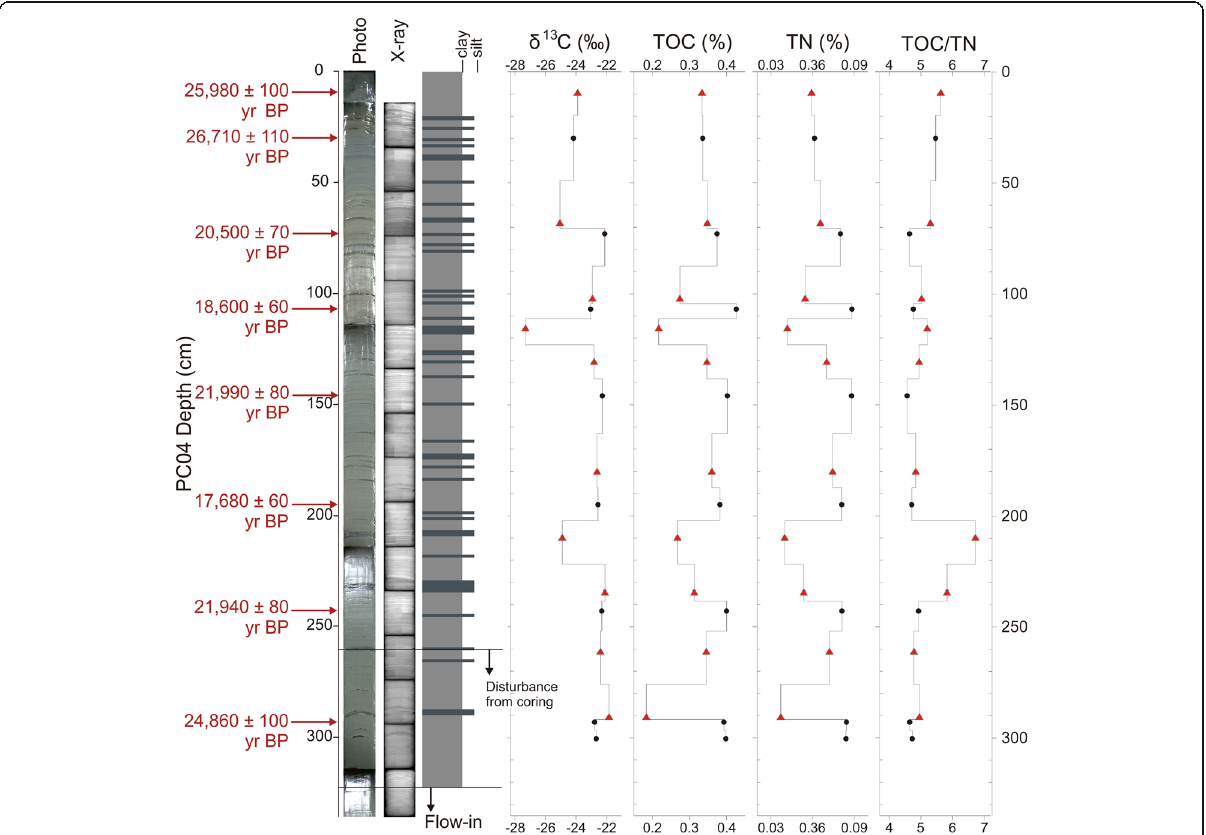
Fig. 7 Geochemical results from core PC04, including radiocarbon ages, stable carbon isotopic compositions ( δ 13 C), total organic carbon contents (TOC), and total nitrogen contents (TN). Eight radiocarbon ages were determined from bulk sediments at locations marked by red arrows to the left of the section. Ten samples from turbidite beds (red triangles) and eight from hemipelagic sediments (black circles) in specific layers were selected for δ 13 C, TOC, and TN